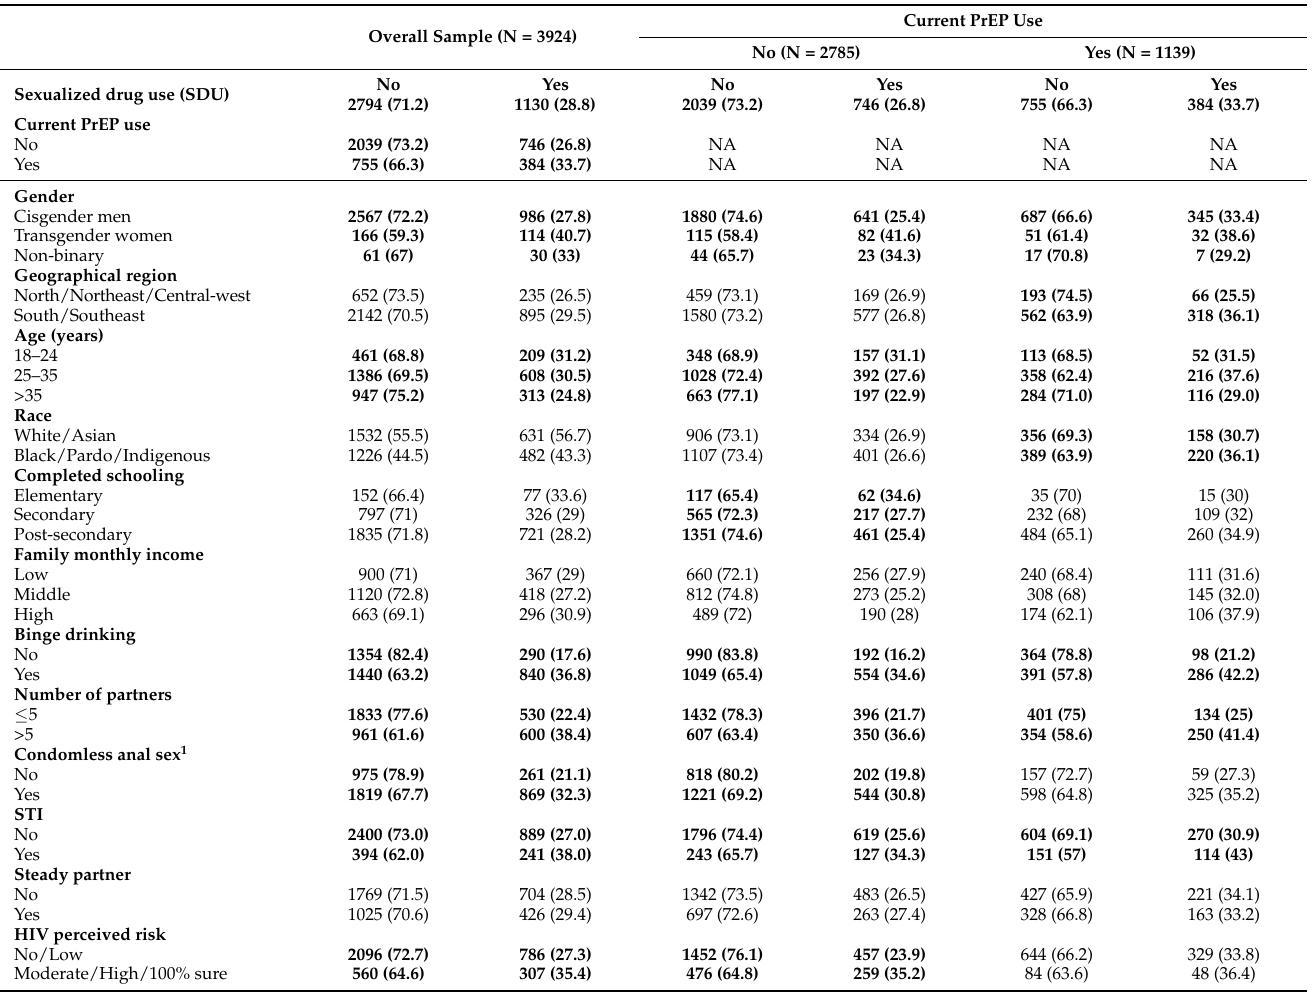
Table 2. Characteristics of the study population stratified by SDU overall and according to PrEP use. Overall Sample (N = 3924) No (N =